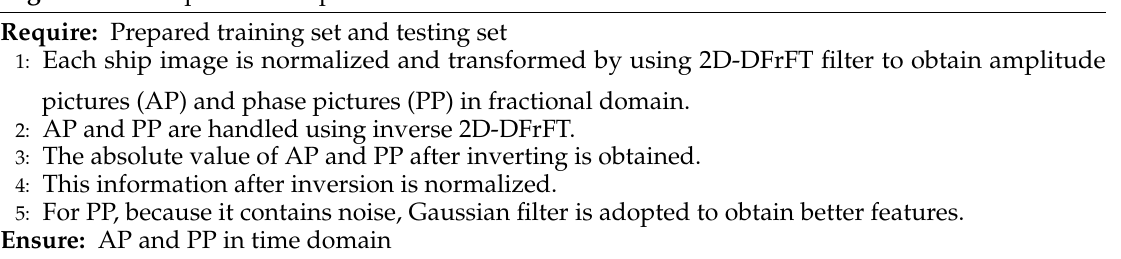
Algorithm 1 Amplitude and phase information